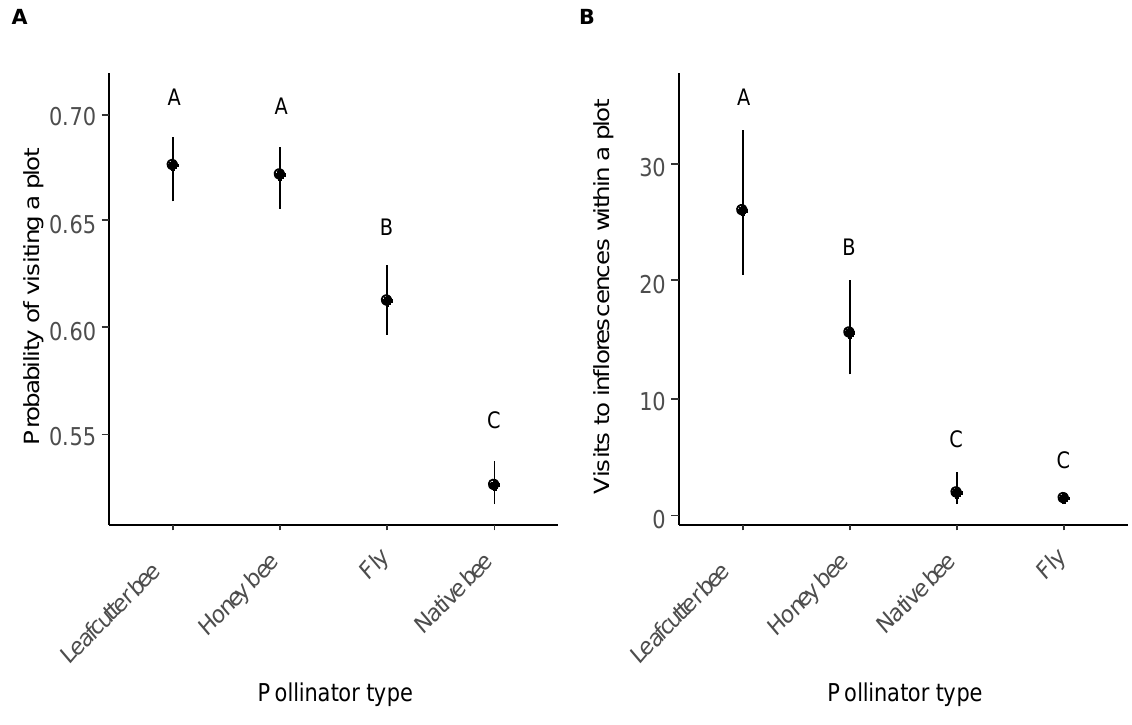
Figure 3. The effect of pollinator type on A) the probability of pollinators visiting a plot and B) the number of visits made to inflorescences within a plot by pollinators during a 10-minute observation of a 1 m 2 plot. The types of pollinators observed include leafcutter bees ( N = 178), honey bees ( N = 147), native bees ( N = 26), and flies ( N = 106). Points represent the model- adjusted means and lines represent the 95% CI. Letters indicate significant differences among means ( P < 0.05); means followed by a common letter are not significantly different at the 5% level of